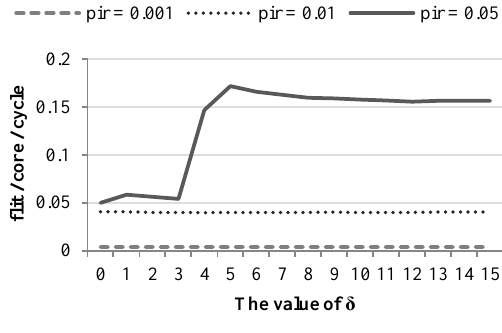
Figure 7. Effect of δ on the average throughput for different values of pir.